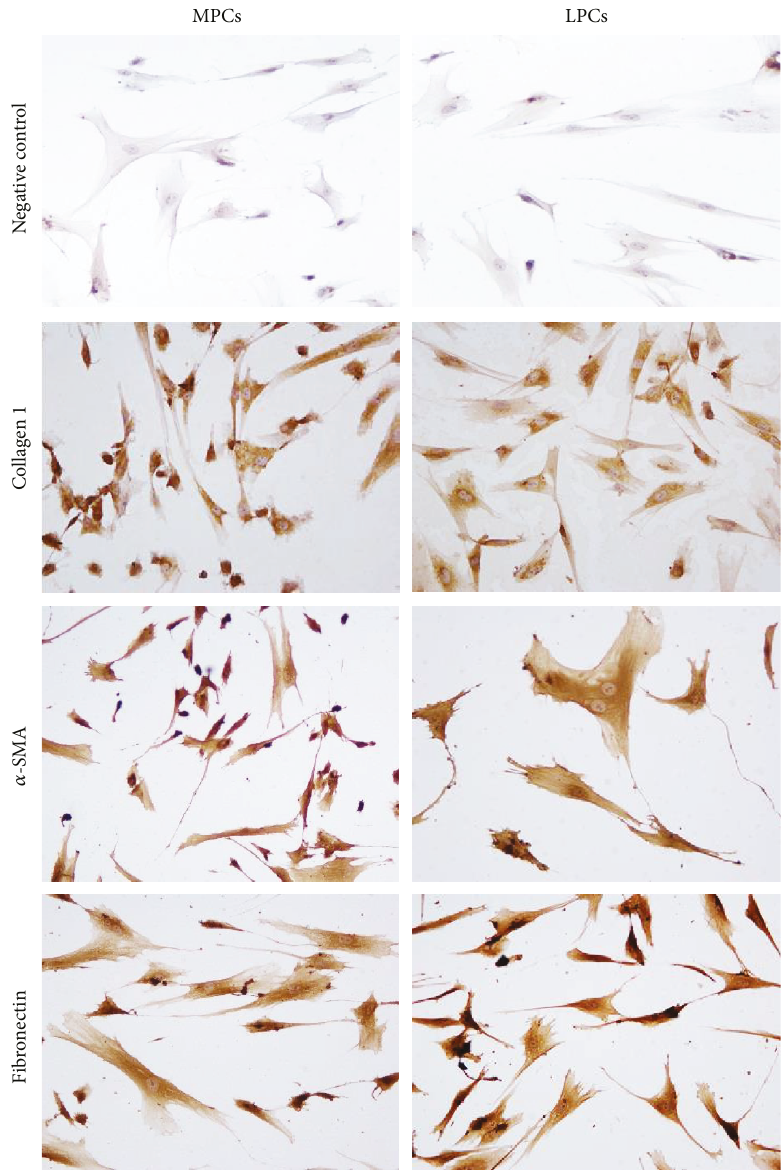
Figure 6: Immunocytochemical analysis of α -SMA, collagen type 1, and fi bronectin. Compared to the negative control (secondary antibody alone), the primary antibodies induce brownish staining in myometrium progenitor cells (MPCs) and leiomyoma progenitor cells (LPCs). The reaction was weaker for collagen type 1 than for α -SMA and fi bronectin. Di ff erences between MPCs and LPCs were not signi fi cant (immunoperoxidase, × 400 original magni fi